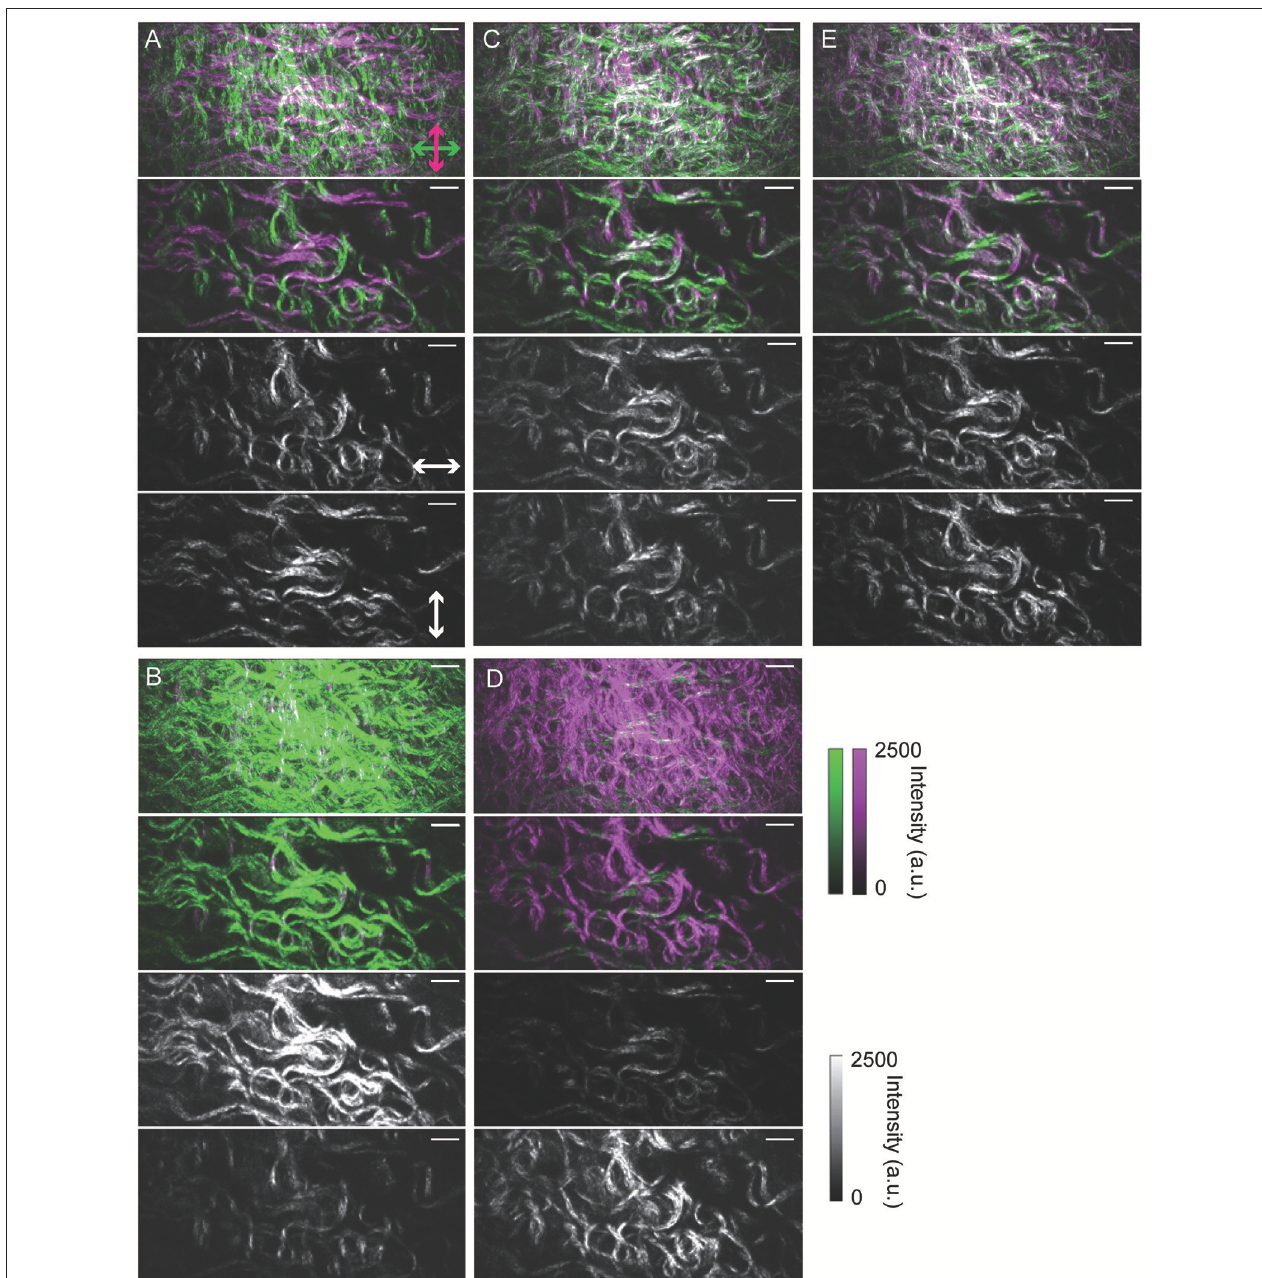
FIGURE 4 | Polarization-resolved SHG images of collagen fibers in a fixed mouse skin sample. (A) Under irradiation of circularly polarized light. (B–E) Under irradiation of linearly polarized light. Images taken when lateral polarization angles were set to 0, 45, 90, and 135 ◦ from the horizontal axis of the FOV are shown in (B–E) , respectively. In (A–E) , the upper images are maximum intensity projection SHG images from Z-stacks (50 µ m thick) taken at 1.0 µ m intervals. The upper-middle, lower-middle, and lower images are merged, horizontal, and vertical SHG images taken 13 µ m from the specimen surface, respectively. In each sectioned image, the exposure time was 300ms, the pixel size was 230nm × 230nm, and the FOV size was 118 µ m × 56 µ m (512 pixels × 242 pixels). Scale bars indicate 10 µ m